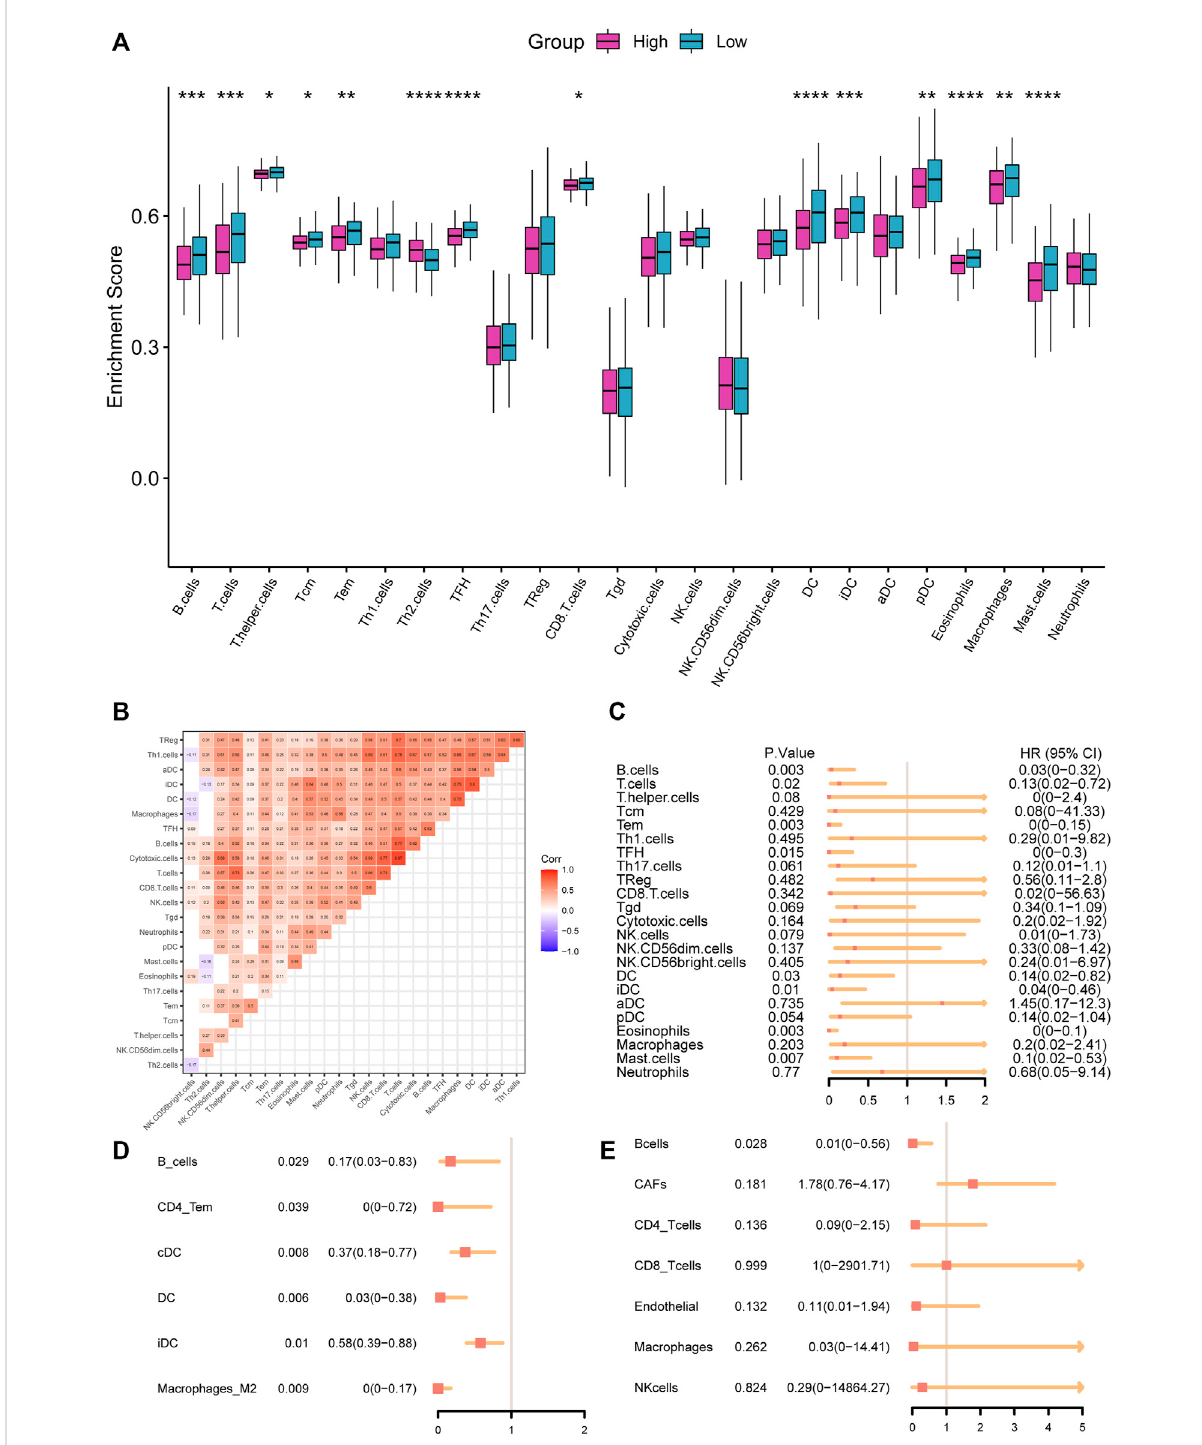
FIGURE 7 (A) Comparisons of in fi ltration levels of immune cells between high- and low-RS groups with the ssGSEA algorithm. (B) The correlation of the tumor-in fi ltrated immune cells. (C – E) Forest plot of the tumor-in fi ltrated immune cells with ssGSEA (C) , xCell database (D) , and EPIC database (E)